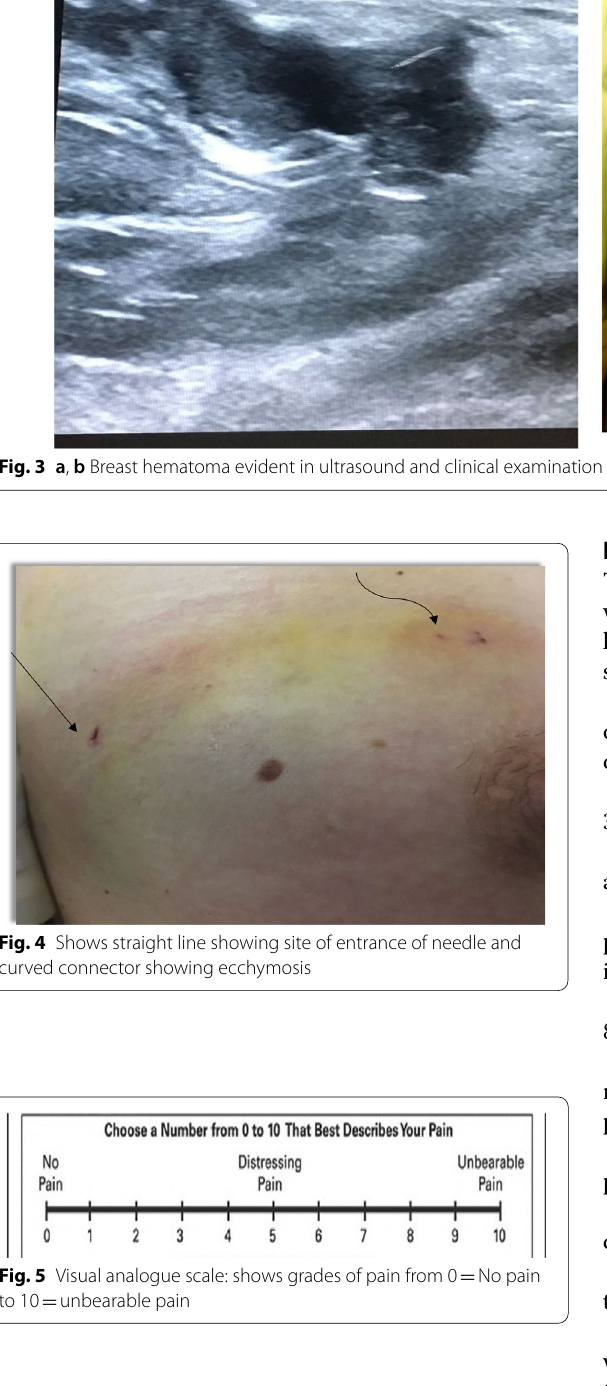
the expected frequency is less than 5. Correlations between quantitative variables were done using Spear- man correlation coefficient. P values less than 0.05 were considered as statistically significant.